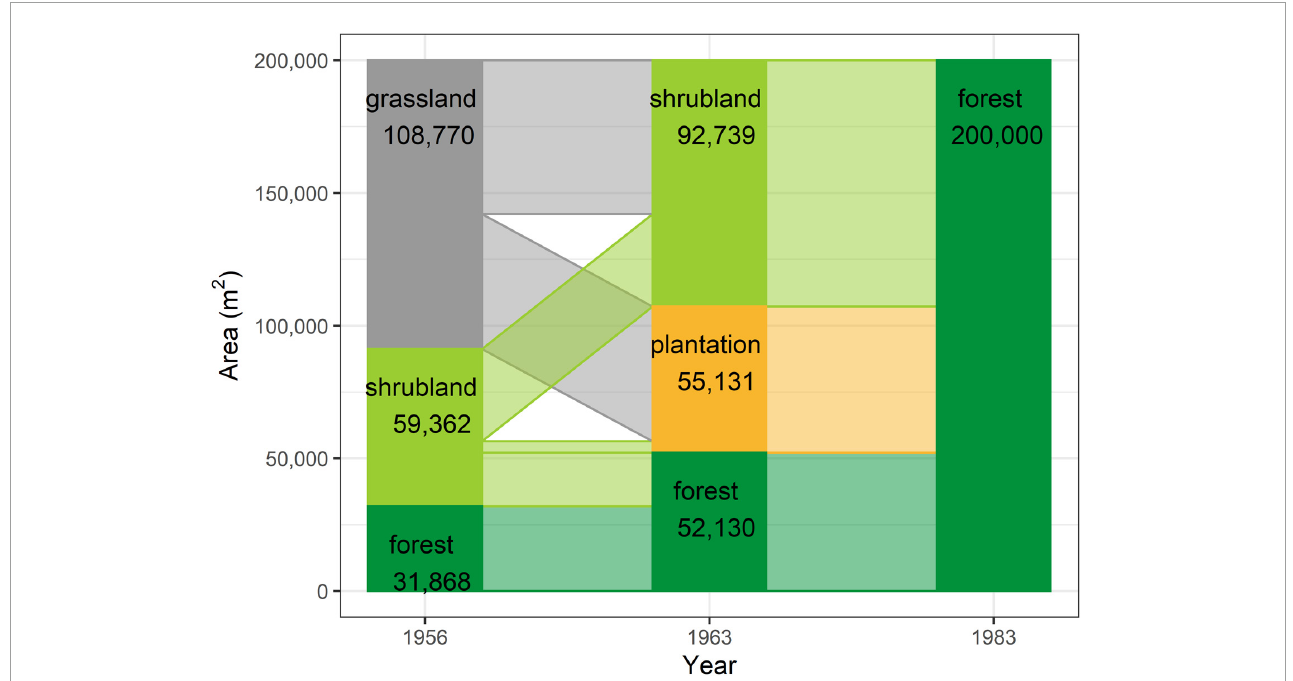
FIGURE3 Schematic representation of the area accounted for by each vegetation type within the TPK plot at each time point.